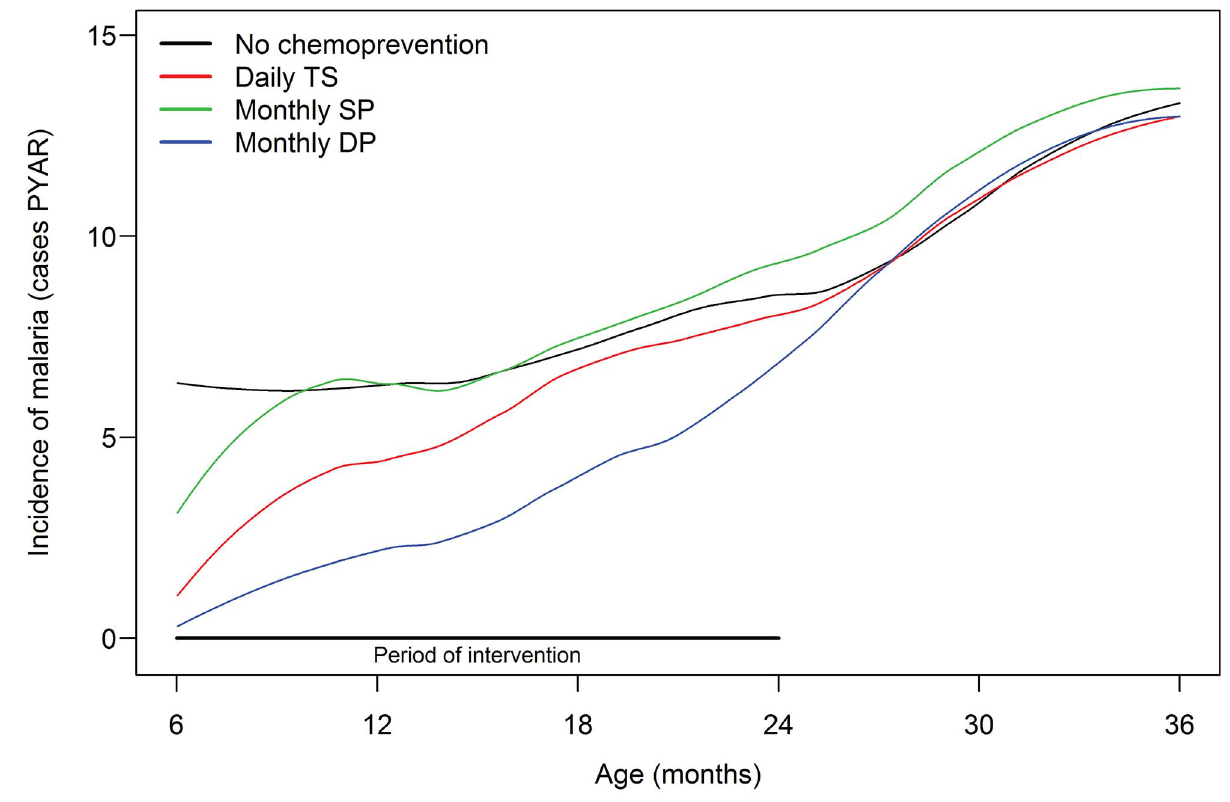
Figure 2. Incidence of malaria over age, stratified by assigned study arm. PYAR, person-years at risk. doi:10.1371/journal.pmed.1001689.g002 PLOS Medicine |